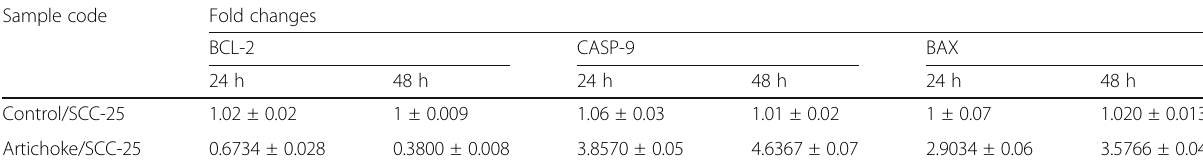
Table 3 Mean values and measures of variability (SE) of studied genes expression in control and artichoke SCC-25 cell lines in relation to the time of influence using paired Student ’ s t test